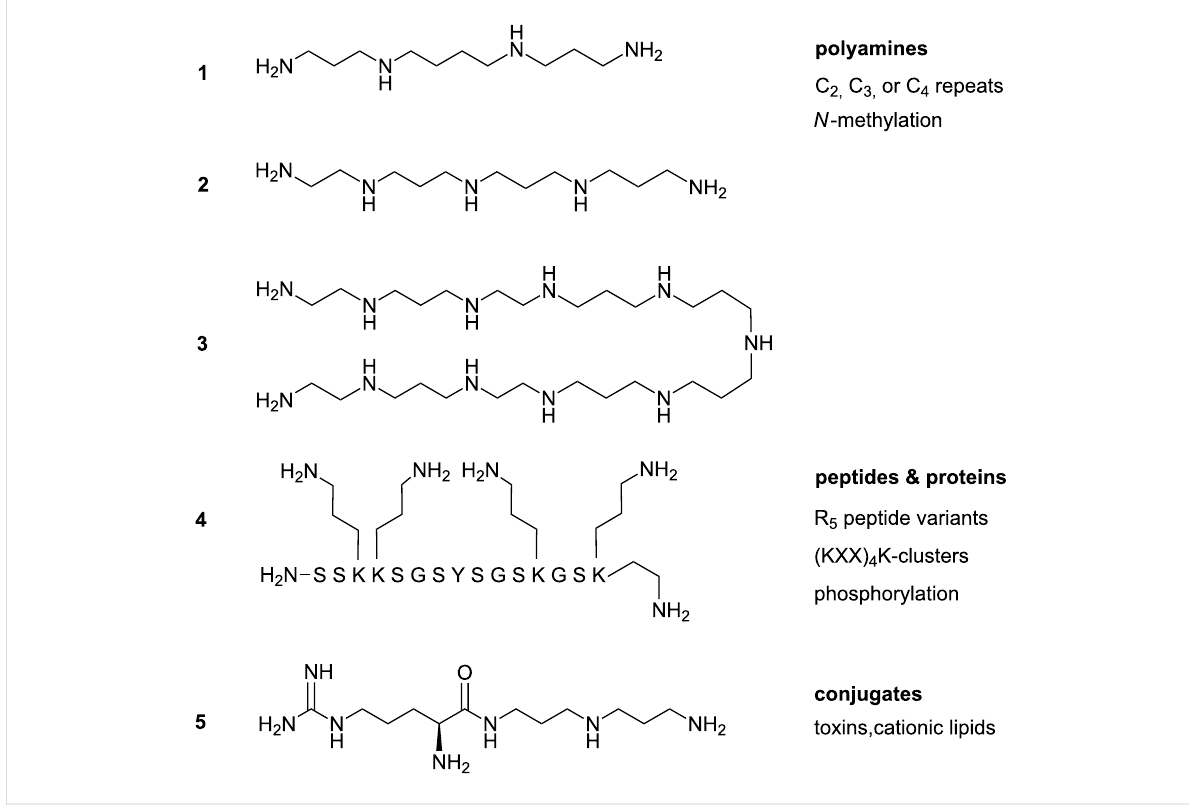
Figure 2: The polyamines 1 , 2 , and 3 have increasing numbers of 4, 5 and 11 basic nitrogens. Peptide 4 is a simplified sequence derived from the silaffins and bears 6 primary amines. Amino acids are characterized by the one-letter code (S Serin, K Lysin, G Glycin, Y Tyrosine). Toxine 5 is the condensation product of Arginine and